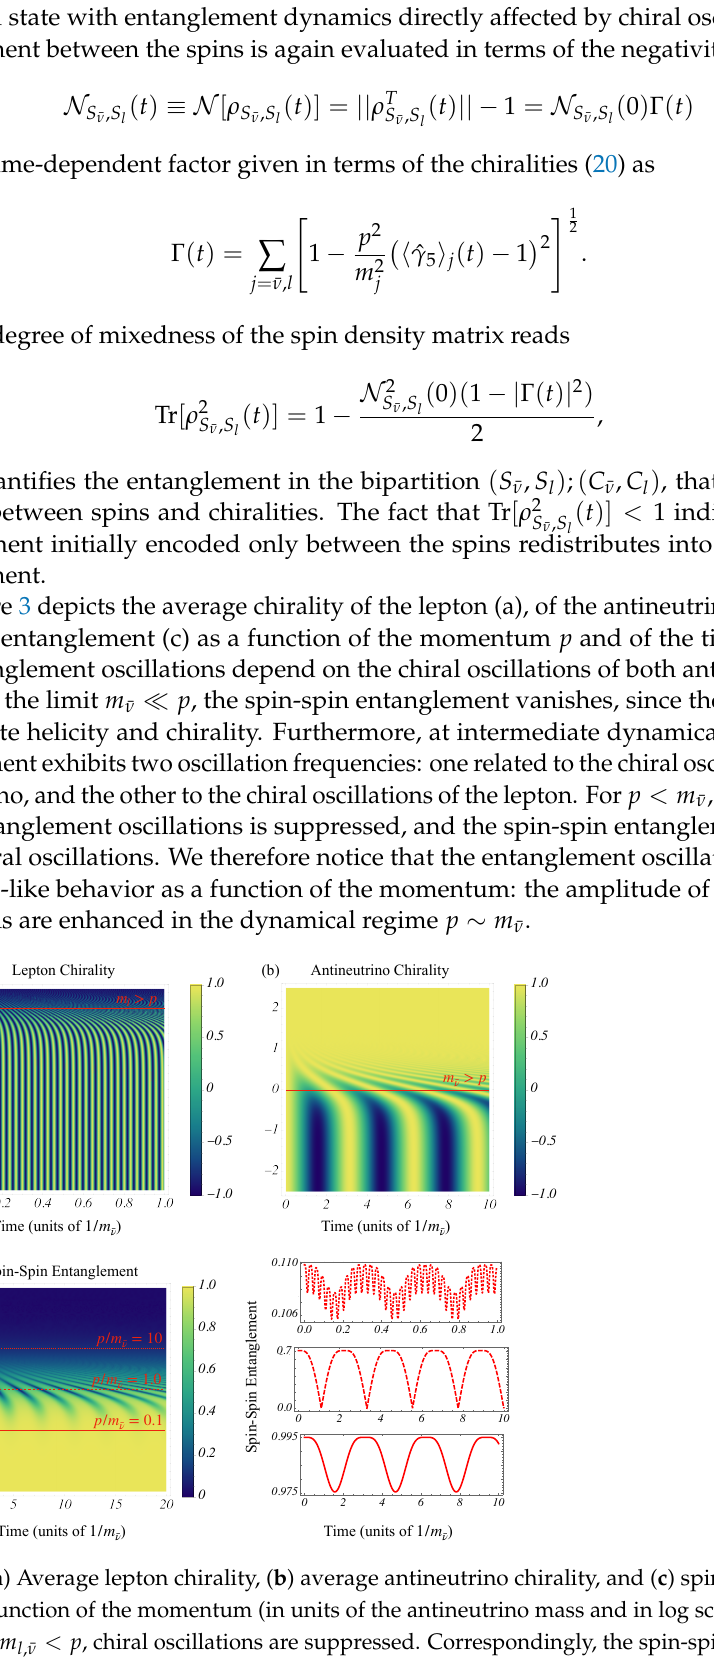
p , entanglement is suppressed. (cid:28)